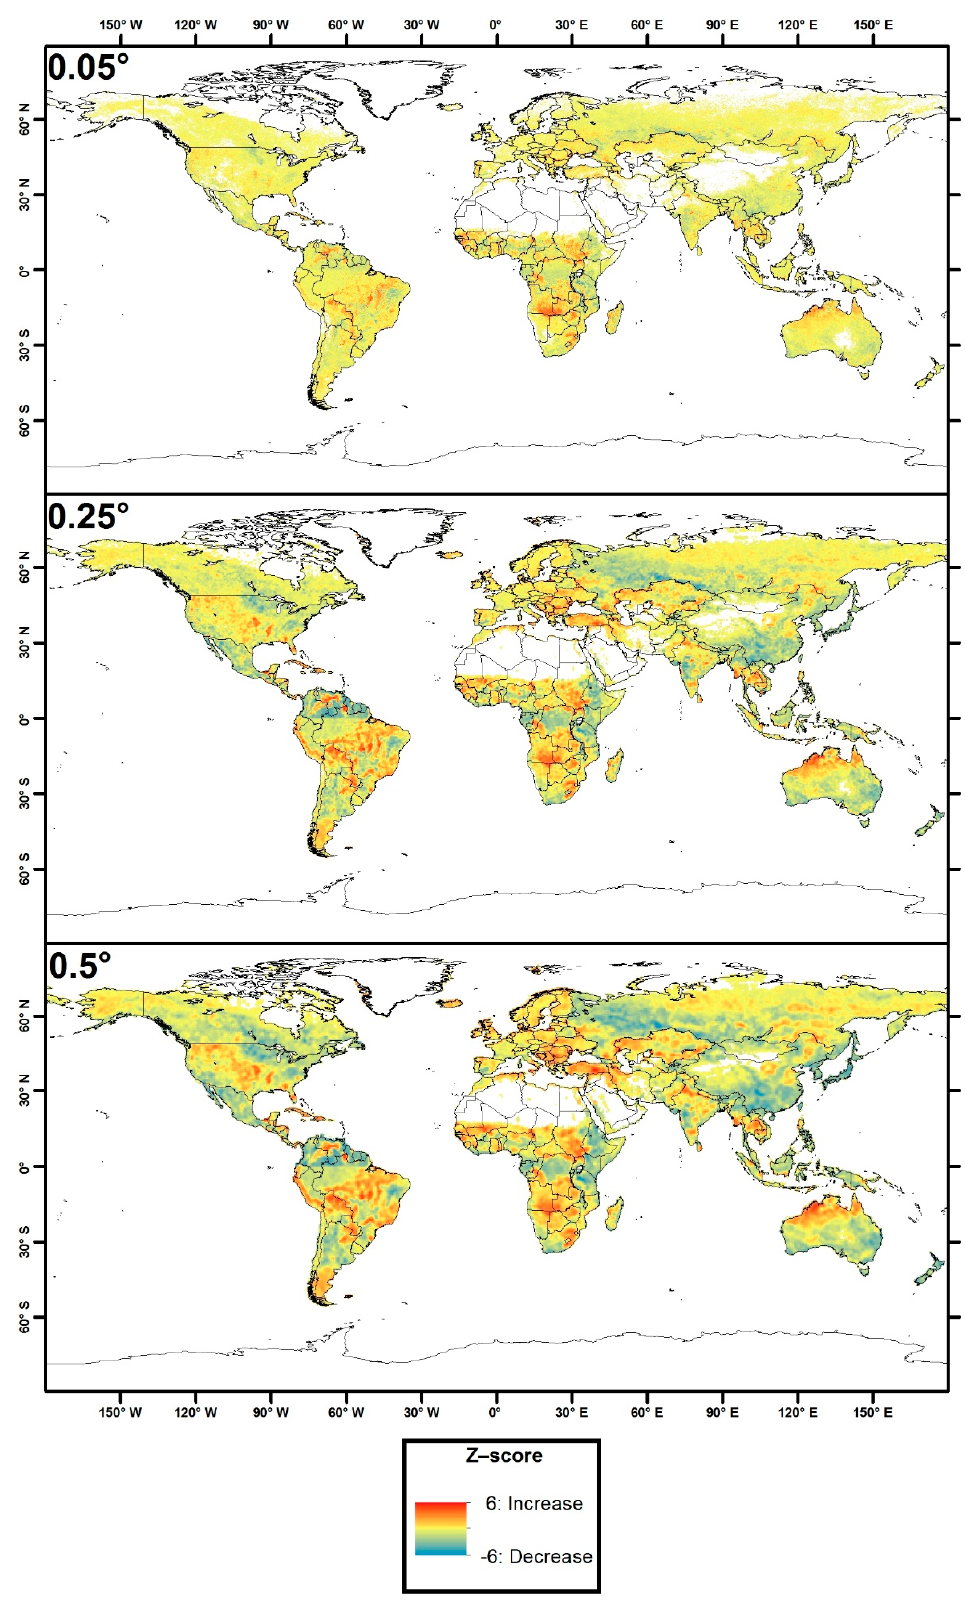
Figure 2. Comparison of Z–score, obtained by the CMK approach, between the three different spatial resolution in the FireCCILT11 (1982–2018) dataset.